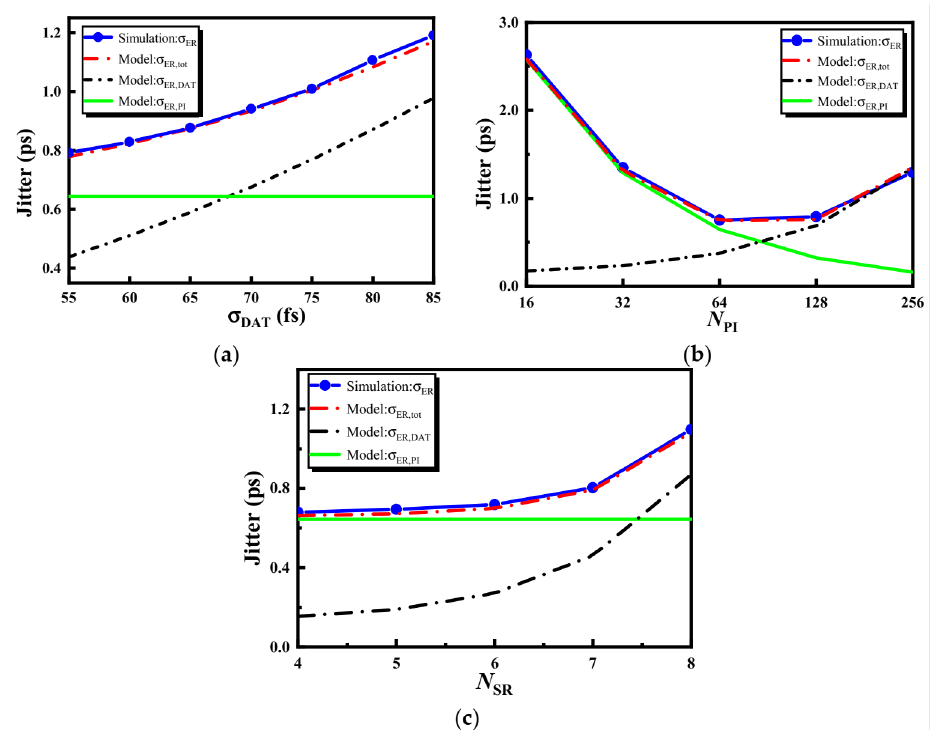
Figure 10. Comparison of model and simulation results of the error jitter with various ( a ) σ DAT , ( b ) N PI , and ( c ) N SR